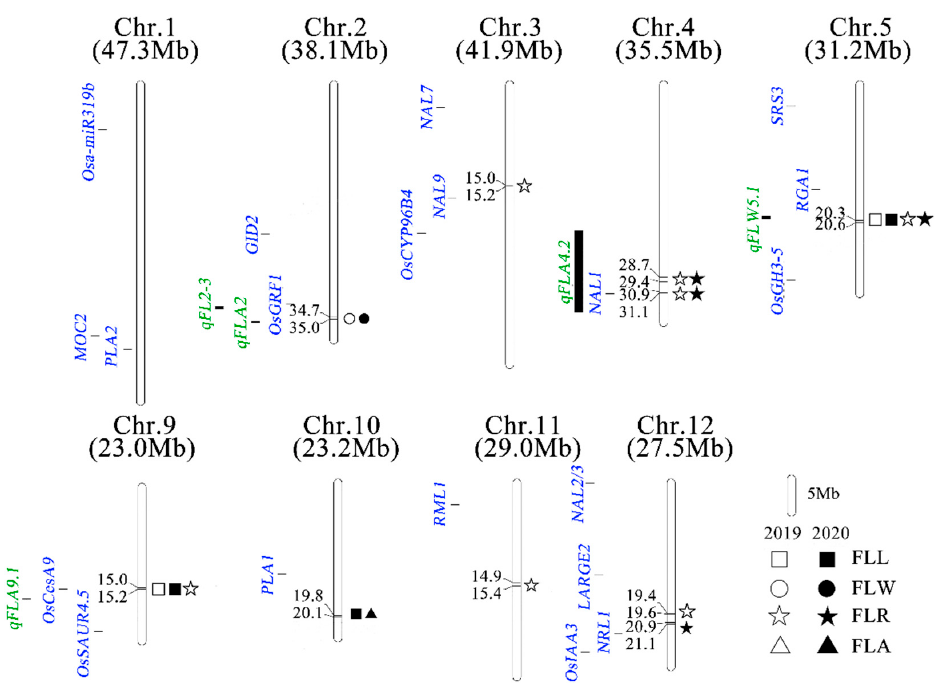
Figure 10. QTLs detected in natural populations in 2019 and 2020 with MLM. Blue and green colors represent genes and QTLs reported in previous studies, respectively.